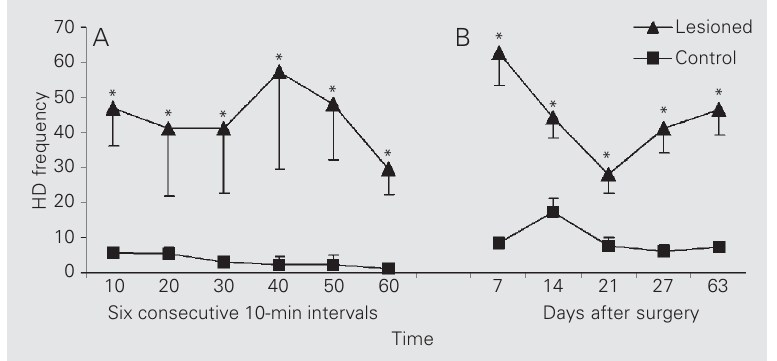
Figure 1. Frequency of head dipping (HD) displayed by median raphe nucleus-lesioned (triangles) and sham-operated rats (squares) during 10-min periods in the elevated endless maze. A , HD frequencies observed in 4 rats of each group during 6 consecutive intervals 8 to 10 days after surgery. Data are reported as means ± SEM. B , HD counted in 7 lesioned and 8 sham-operated rats on different days after surgery. *P < 0.05 compared to control (Mann-Whitney